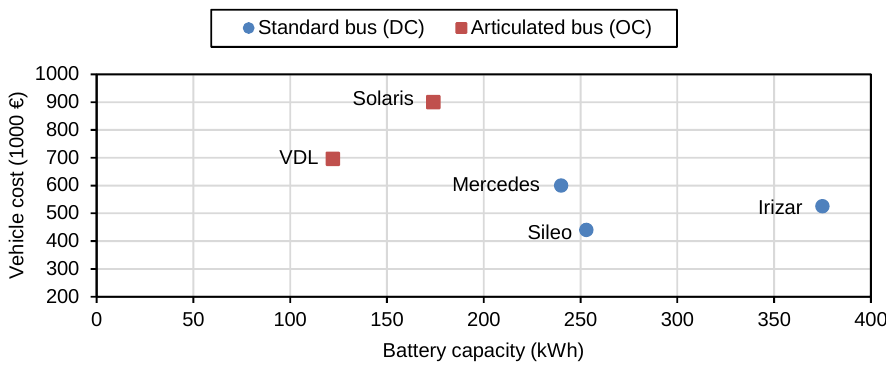
Figure 17. Comparison of vehicle cost reported in the literature